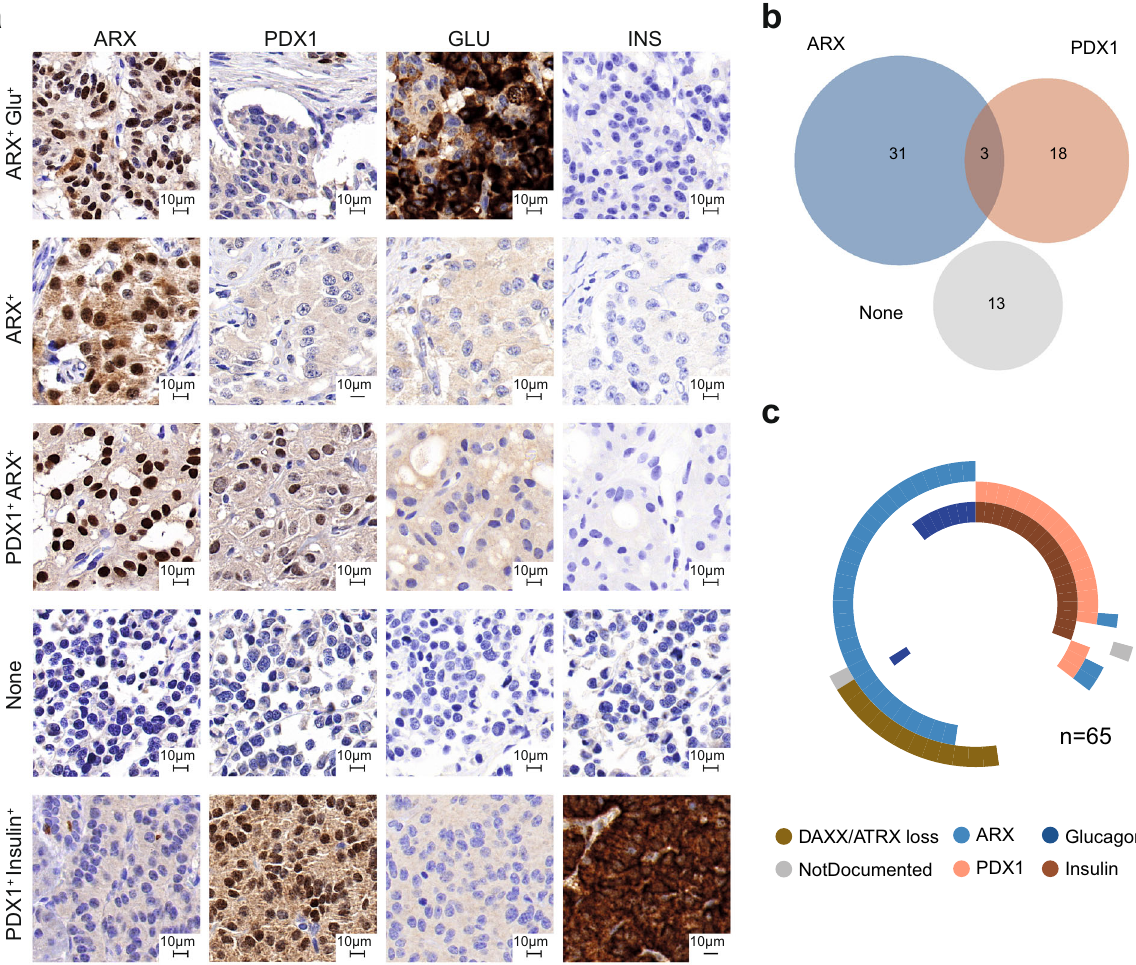
Fig. 2 Expression of ARX, PDX1, insulin, and glucagon can be used as surrogate for de fi ning tumour cell-type speci fi city. a Immunostaining for the different subtypes of PanNETs. From the top to the bottom: tumour positive for ARX and glucagon; tumour positive for ARX; double positive tumour for PDX1 and ARX; double negative tumour for ARX and PDX1; tumour positive for PDX1 and insulin. For the TFs only nuclear staining was considered for scoring. b Venn diagram displaying the total number of samples positive for ARX and/or PDX1or negative for both the transcription factors. c Schematic overview of the PanNET subtypes in cohort 2. Doughnut chart for all samples showing glucagon, insulin, PDX1 and ARX positivity as well as loss of DAXX/ ATRX